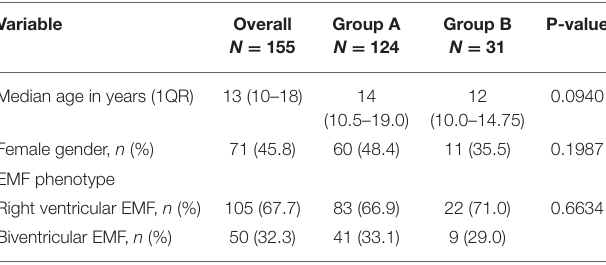
TABLE 1 | Showing baseline characteristics of EMF